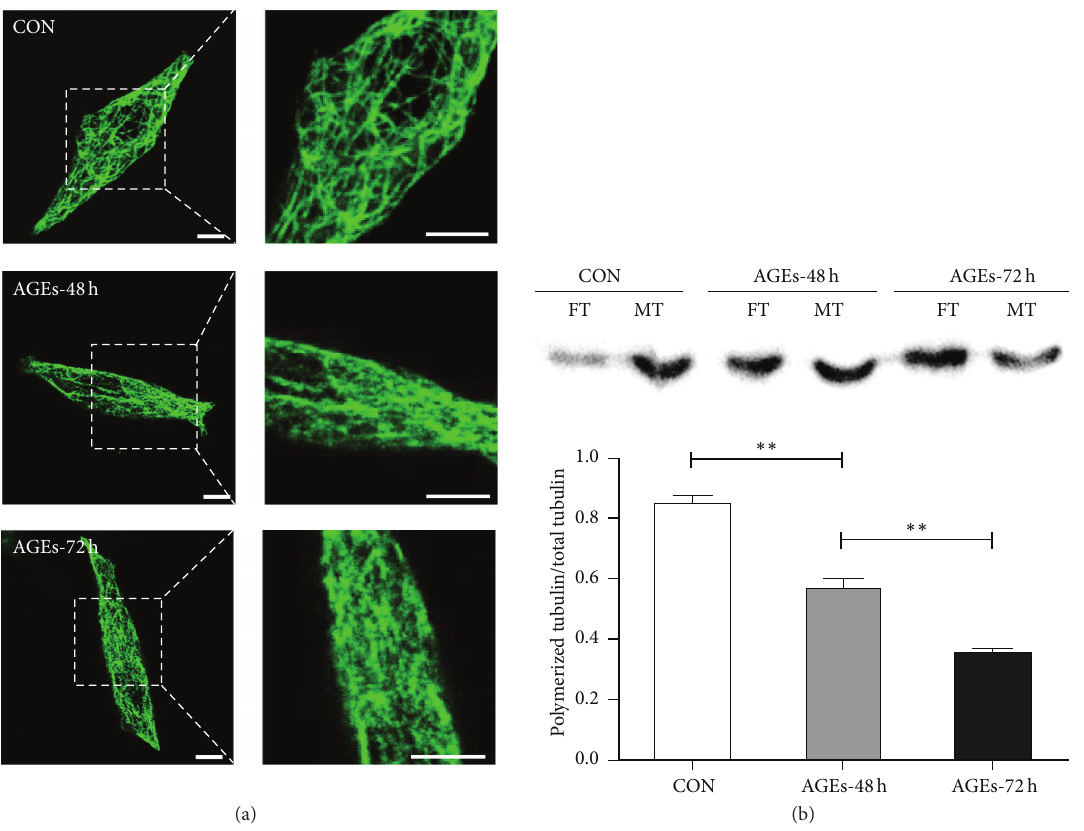
Figure 3: The effect of AGEs on microtubule dynamics in INS-1-3 cells. (a) Immunostaining images of 𝛼 -tubulin (green) in INS-1-3 cells incubated with or without AGEs. CON: INS-1-3 cells without treatment; AGEs-48 h and AGEs-72 h: INS-cells treated with AGEs (200 𝜇 g/mL) for 48 or 72 hours, respectively. Scale bar: 25 𝜇 m. The boxed areas are shown at higher magnification in the right panels to illustrate details of microtubules. (b) The immunoblots of tubulin from soluble and insoluble fractions of INS-1-3 cells (CON) and AGEs-treated cells. Soluble and insoluble fractions containing free tubulin (FT) and polymerized tubulin (MT) were probed with anti- 𝛼 -tubulin antibody. One of the representative results is shown. Statistical analysis was performed based on three immunoblotting results. The polymerization status of tubulins is presented as the percentage of polymerized tubulin divided by the total tubulin content (sum of densitometric values of free and polymerized tubulins). Data are shown as mean ± SD. ∗∗ 𝑝 < 0.01